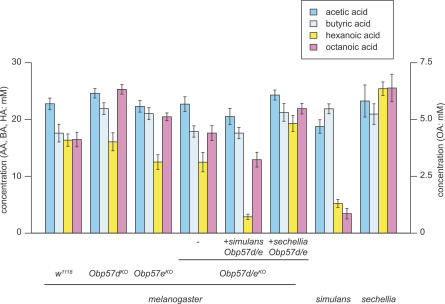
Preferred Concentration of Acids in Oviposition Site–Preference AssayStaged females were individually provided with four types of medium containing each acid at different concentrations. The concentrations were 0 mM, 10 mM, 20 mM, and 30 mM for acetic acid (AA), butyric acid (BA), and hexanoic acid (HA), and 0 mM, 2.5 mM, 5 mM, and 7.5 mM for octanoic acid (OA). The number of eggs laid on each medium was scored, and the weighted mean of acid concentration was calculated individually. Each bar represents a mean of 36 individuals from three replications. Error bars indicate standard error.